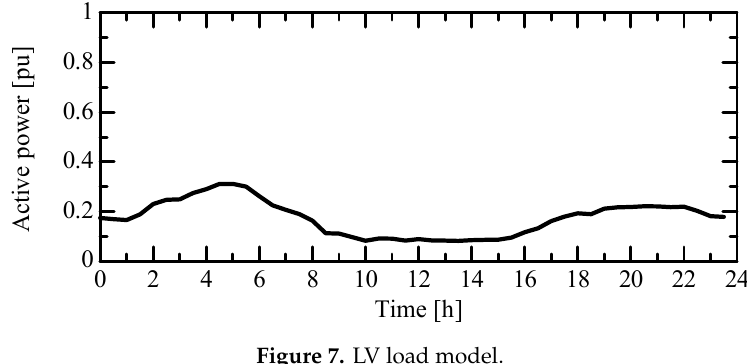
Figure 7. LV load Figure 7. LV load model.